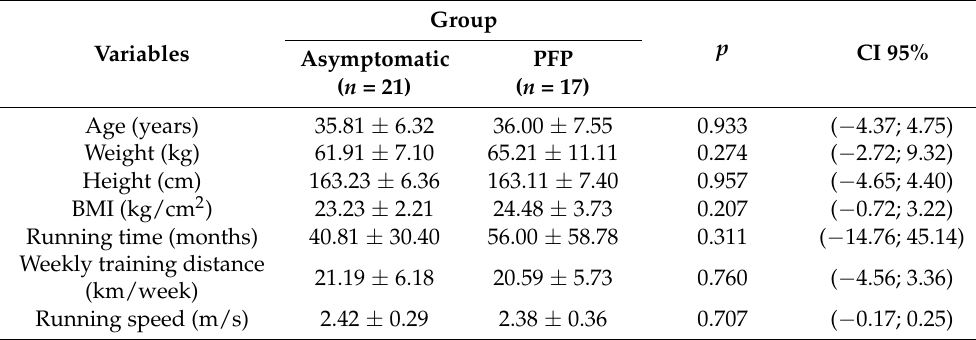
Table 1. Means and standard deviations (SDs) of age, anthropometric data, running time and weekly training distance in asymptomatic and PFP groups.